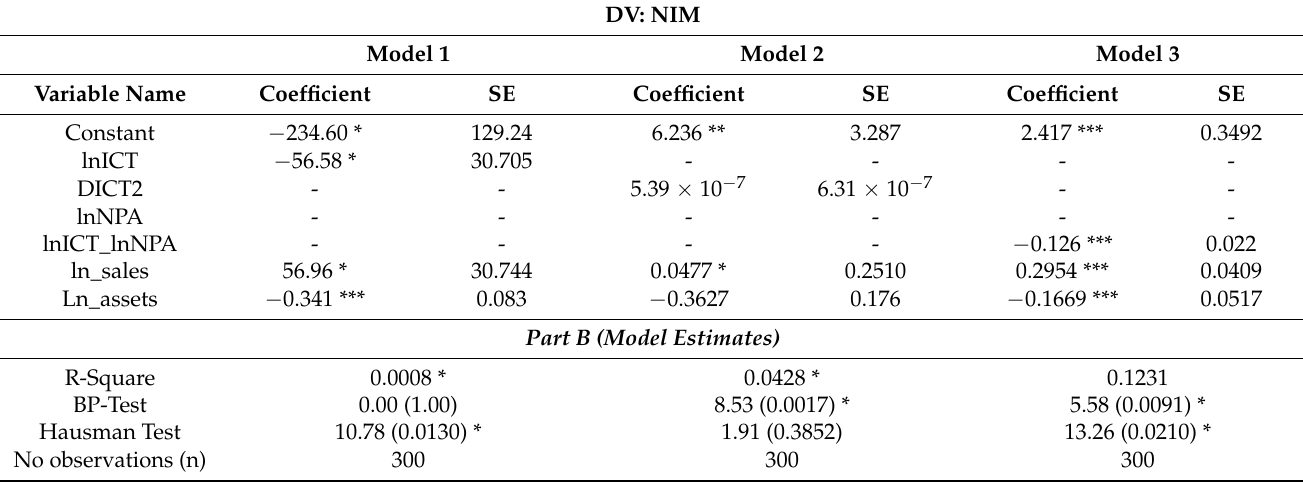
Table 3. Results of Regression Analysis (Model 1) (Fixed Effect